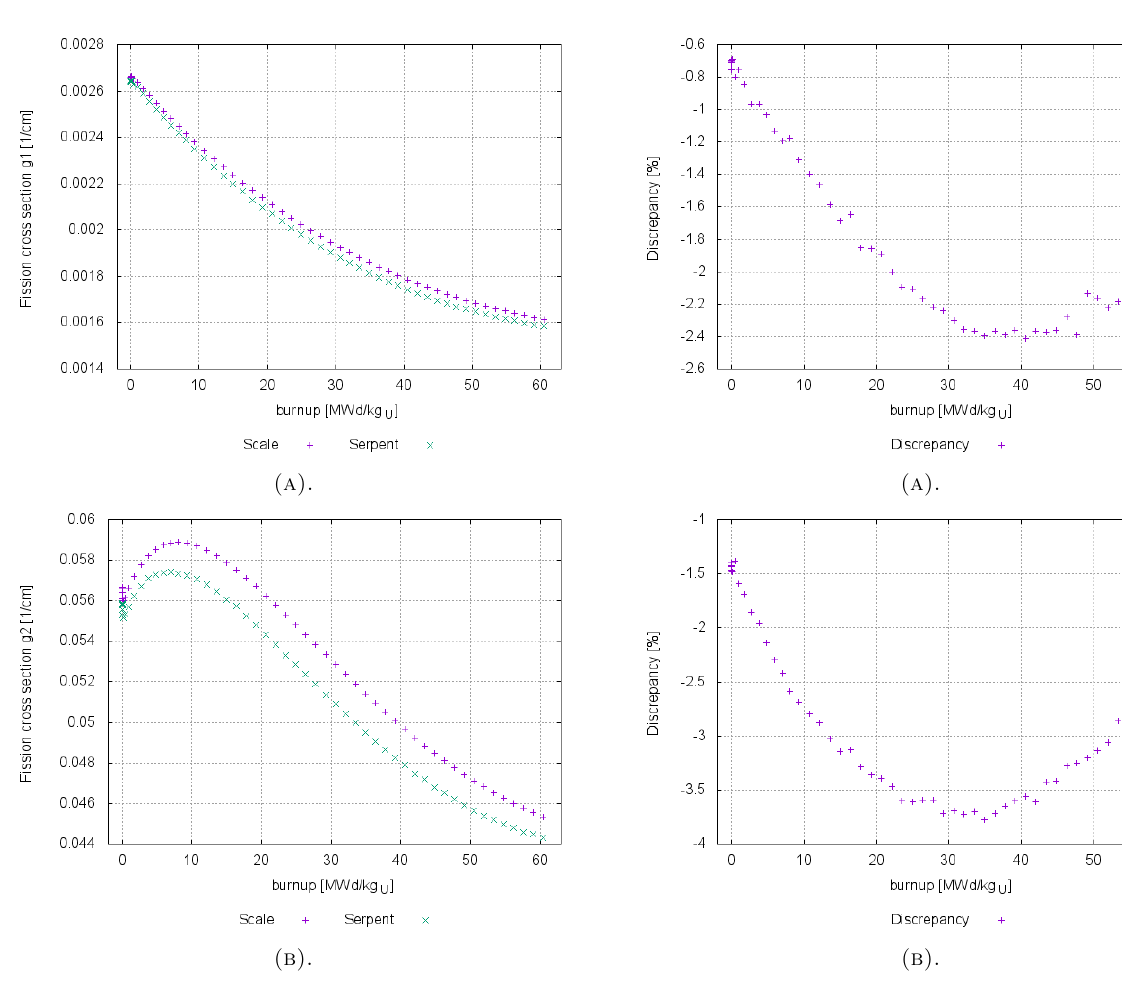
Figure 5. Fission cross-section dependency on bur- nup for fast group (a) and for thermal group (b).